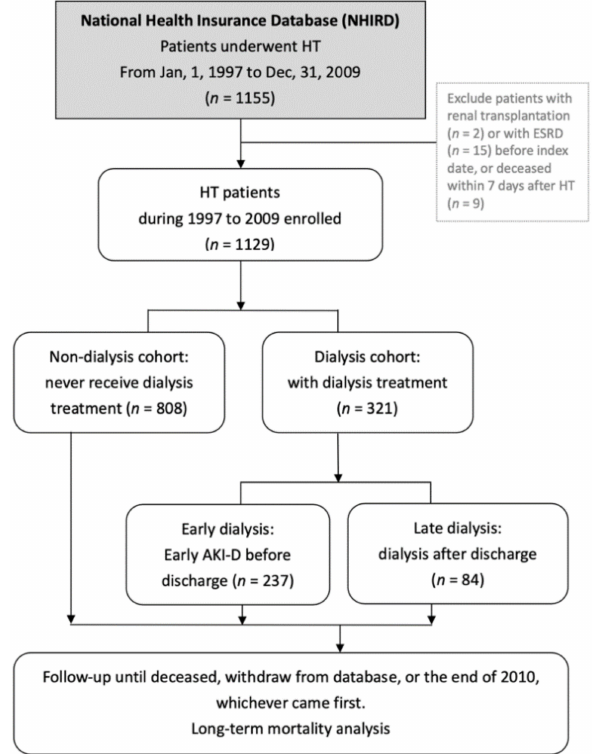
Figure 1. Flow chart of patient selection. Abbreviations: HT, heart transplantation; ESRD, end-stage renal disease; AKI-D, acute kidney injury requiring